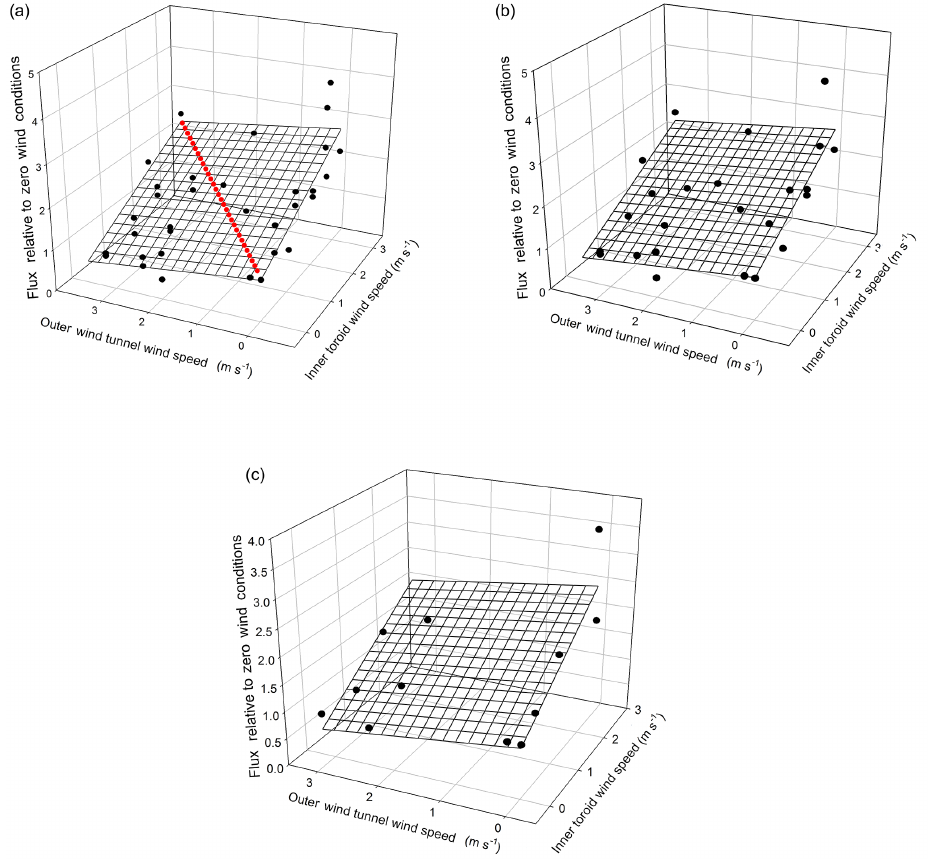
Figure 3. (a) Relationship between wind speeds internal and external to the toroid and relative flux rates for both CO 2 ( n = 27) and CH 4 ( n = 12). Planar surface indicates best fit to data (FR = 0 . 99 + 0.55 × IT WS − 0.13 × OWT WS; r 2 = 0 . 67). The shaded red line represents equal wind speeds inside and outside the flux chamber, where z = 0 . 99 + 0.42 × IT/OWT WS (ms − 1 ). Separate CO 2 and CH 4 flux relation- ships are shown in (b, c) . (b) The relationship between wind speeds internal and external to the toroid and relative CO 2 fluxes ( n = 27). All details as shown in (a) . Planar surface indicates best fit to data ( z = 1 . 01 + 0.52 × IT WS − 0.12 × OWT WS; r 2 = 0.66). (c) The relationship between wind speeds internal and external to the toroid and relative CH 4 fluxes ( n = 12). All details as shown in (a) . Planar surface indicates best fit to data ( z = 0 . 94 + 0.61 × internal WS − 0.14 × external WS; r 2 = 0 .